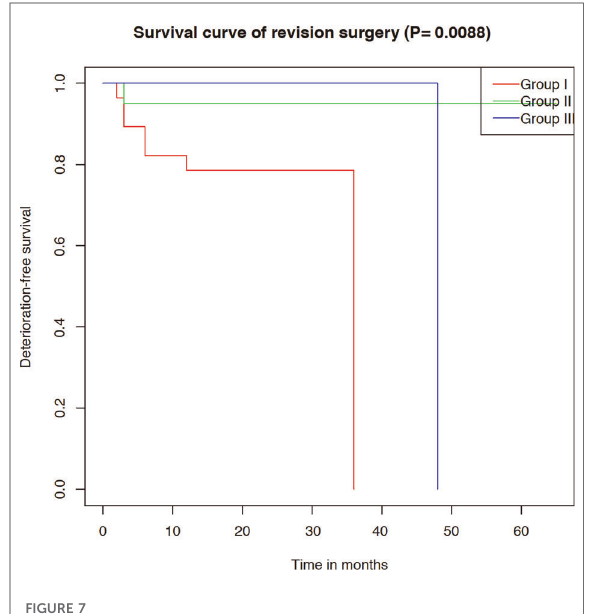
FIGURE 7 Kaplan – Meier analysis illustrating deterioration-free survival in different